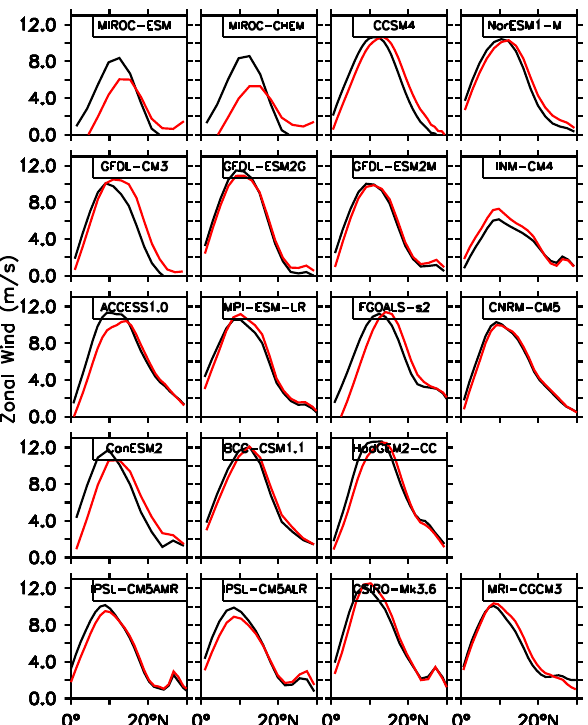
Fig. 14. Meridional pattern of zonal wind (ms − 1 ) averaged over the region 50E–110E for the 19 CMIP-5 models during June– September. Black lines represent JJAS mean zonal wind for the pe- riod 1970–2000, and red lines represent JJAS mean zonal wind for the period